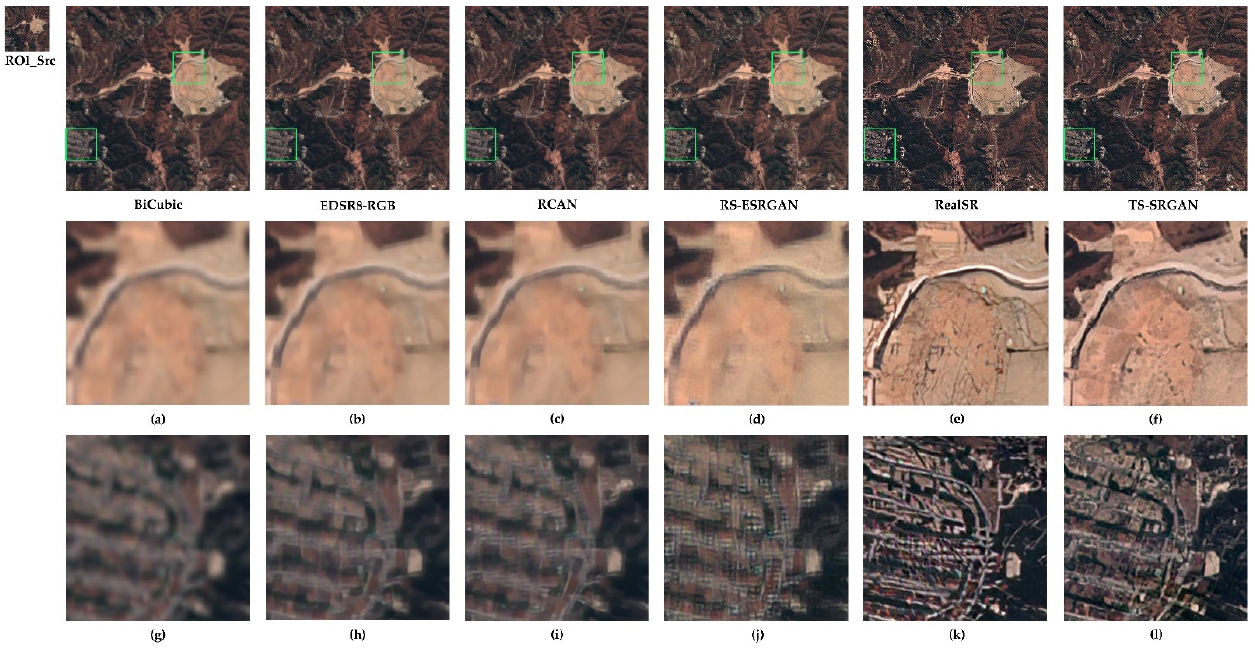
Figure 17. Comparison of visual effects of the generated images of the region containing dry riverbeds and residential houses. NR-IQA of images (NIQE, BRISQUE, PIQE): BiCubic (6.30, 50.23, 100.00), EDSR8-RGB (5.17, 49.48, 73.97), RCAN (4.30, 46.78, 58.43), RS-ESRGAN (3.06, 23.08, 18.75), RealSR (3.23, 12.43, 9.51), TS-SRGAN (2.70, 28.73, 11.47). The subfigures ( a – l ) in the figure represent an enlarged view of the local details in the green boxes in the generated image.